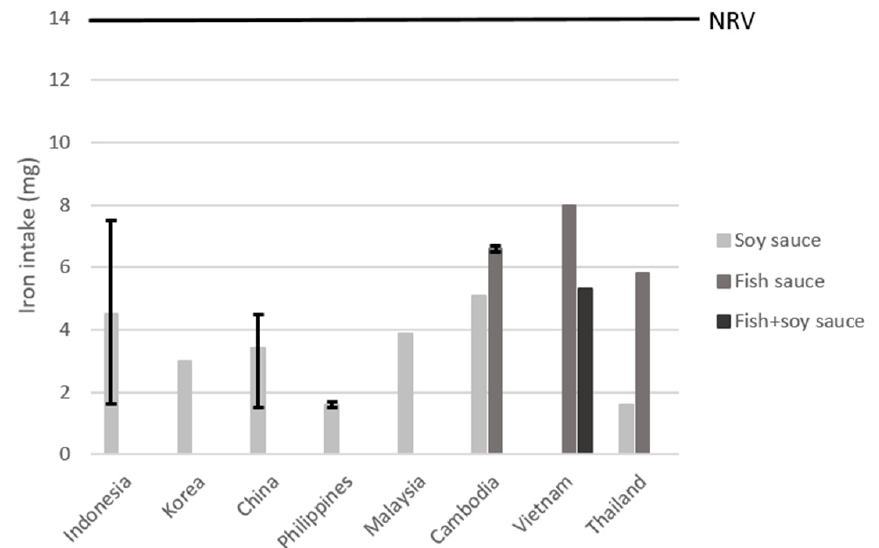
Figure 6. Estimated iron intake after hypothetical fortification of soy and fish sauces with iron fortification levels of 0.5 mg/g product. The error bars represent the highest and lowest value found for the country. NRV = Codex nutrient reference value of 14 mg/day.